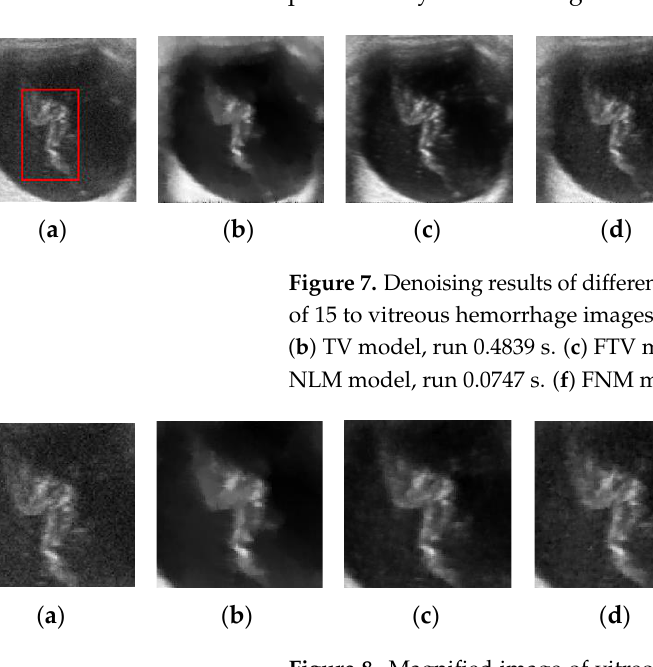
Figure 9. Denoising results of different models after adding Gaussian noise with a standard devia- tion of 15 to vitreous mechanization images. ( a ) Noise image, the red marked area is the part of the lesion. ( b ) TV model, run 0.4956 s. ( c ) FTV model, run 0.9436 s. ( d ) AFOTV model, run 0.5095 s. ( e ) F-DSG-NLM model, run 0.3067 s. ( f ) FNM model, run 14.2753 s. ( g ) Our model, run 358.1444 s. ( a ) ( e ) ( f ) ( g ) Figure 10. Magnified image of vitreous mechanization in part of the lesion. ( a ) Noise image. ( b ) TV model. ( c ) FTV model. ( d ) AFOTV model. ( e ) F-DSG-NLM model. ( f ) FNM model. ( g ) Our model. Figures 7 – 10 show that all six denoising models can remove the noise from the im- ages to a certain extent. The contours of the lesion portion of the image became sharper after the TV model denoised the vitreous hemorrhage image, as shown in Figure 8b. The image became overall more blurred, as shown in Figure 7b. This is due to the diffusion